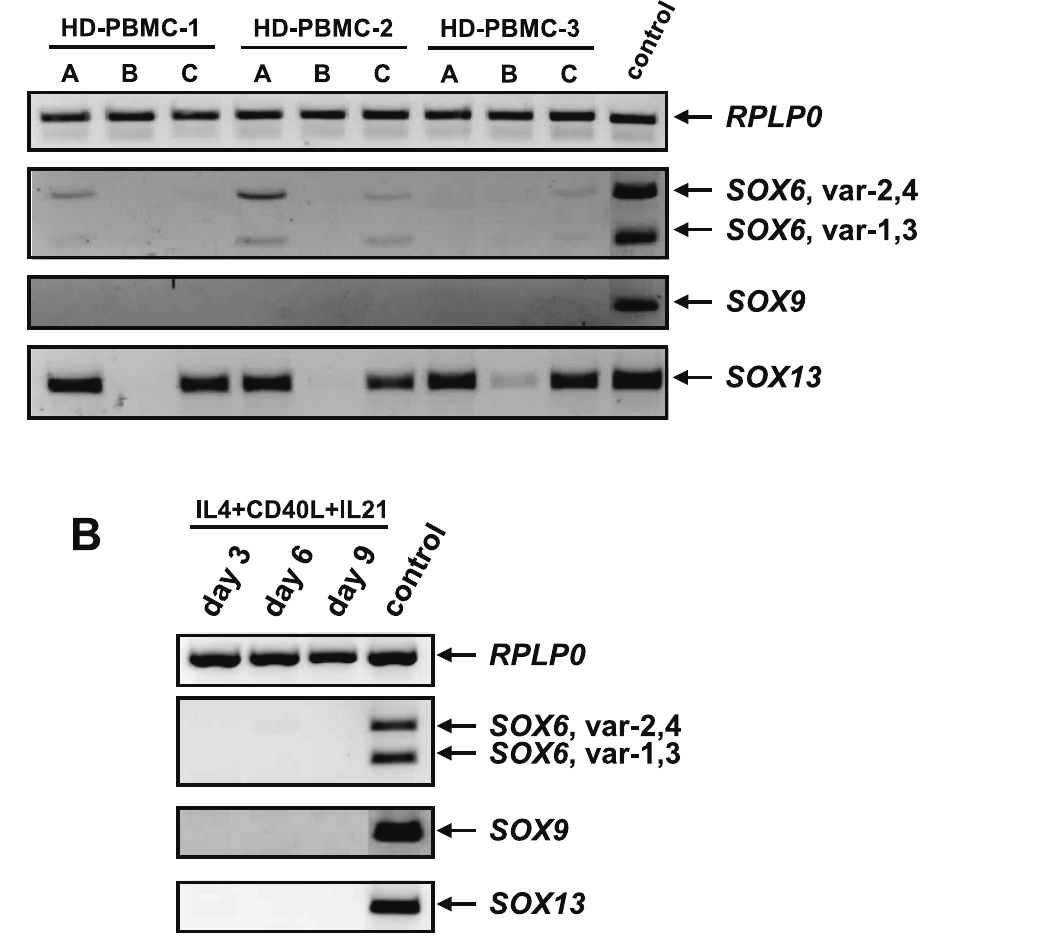
Figure 5. Expression of ‘‘SOX-trio’’ and SOX13 genes in exvivo B cells and during invitro differentiation of human primary B cells. (A) PCR analysis for the expression of RPLP0 , SOX6 , SOX9 and SOX13 genes in human peripheral blood lymphocyte populations: A – PBMCs; B – B cells and C – non-B cell fractions. (B) RPLP0 , SOX6 , SOX9 and SOX13 expression in isolated peripheral blood B cells stimulated with IL4 + CD40L + IL21 for 9 days in vitro . The analysis was performed at days 3, 6 and 9. In agarose gel pictures DNA markers were cut out, since they were loaded between the tested samples and the control sample. Human costal cartilage cells served as a control for SOX6 and SOX9 expression, whereas BEAS-2B cells were used for SOX13 as a